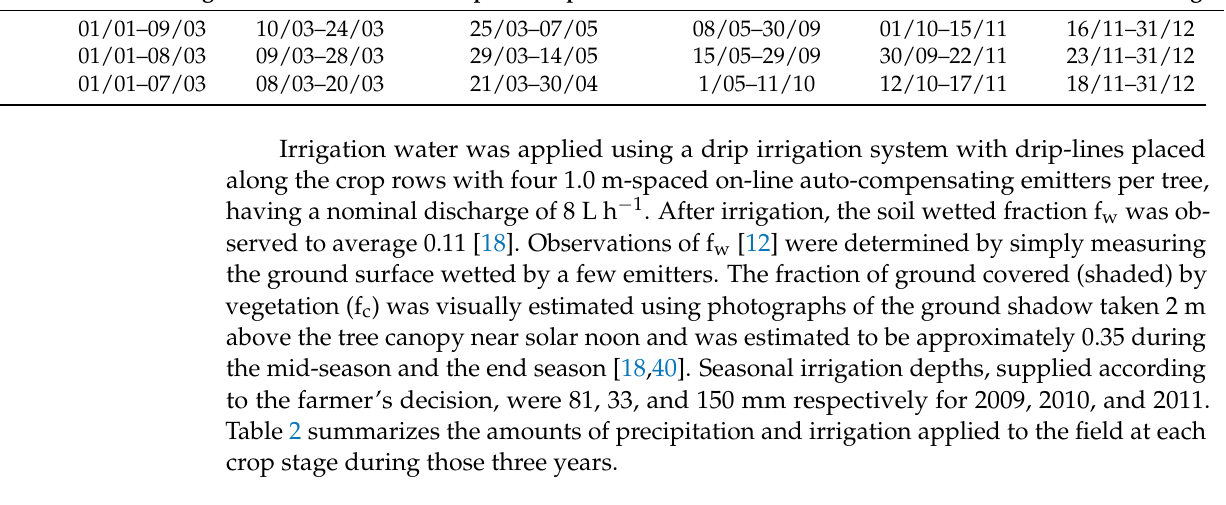
Table 2. Precipitation (mm) and net irrigation depths (mm) in each crop growth stage of the three